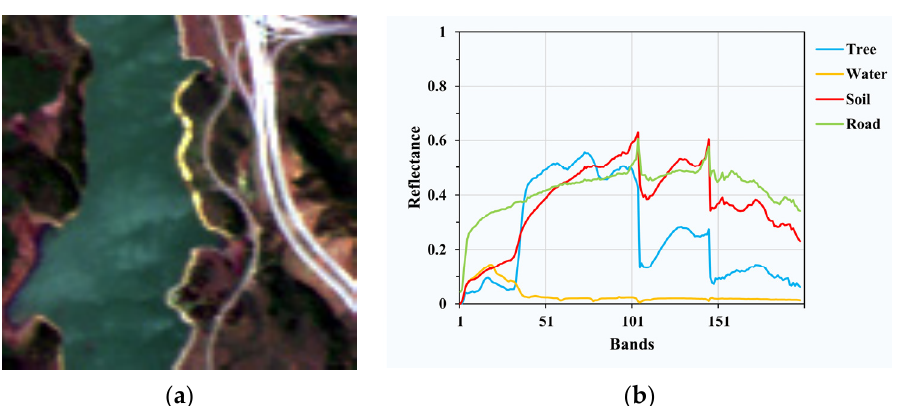
Figure 3. ( a ) Pseudo-color image of Jasper Ridge; ( b ) spectral signatures of endmembers in Jasper Ridge.